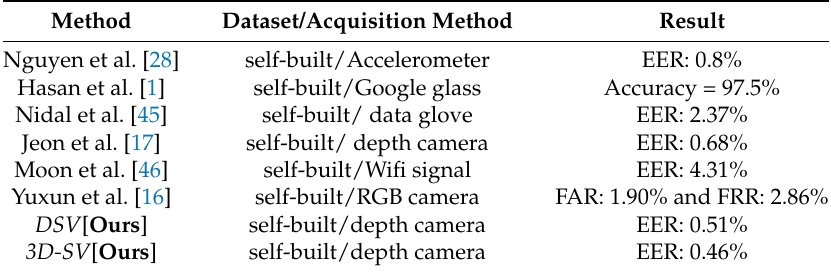
Table 4. The table shows the performances of the existing in-air signature methods and our method. Due to unavailability of a public dataset for in-air signatures, we report results on our dataset. While our 3D-SV module shows the best results, our DSV module, which is based on only depth analysis, shows the competitive